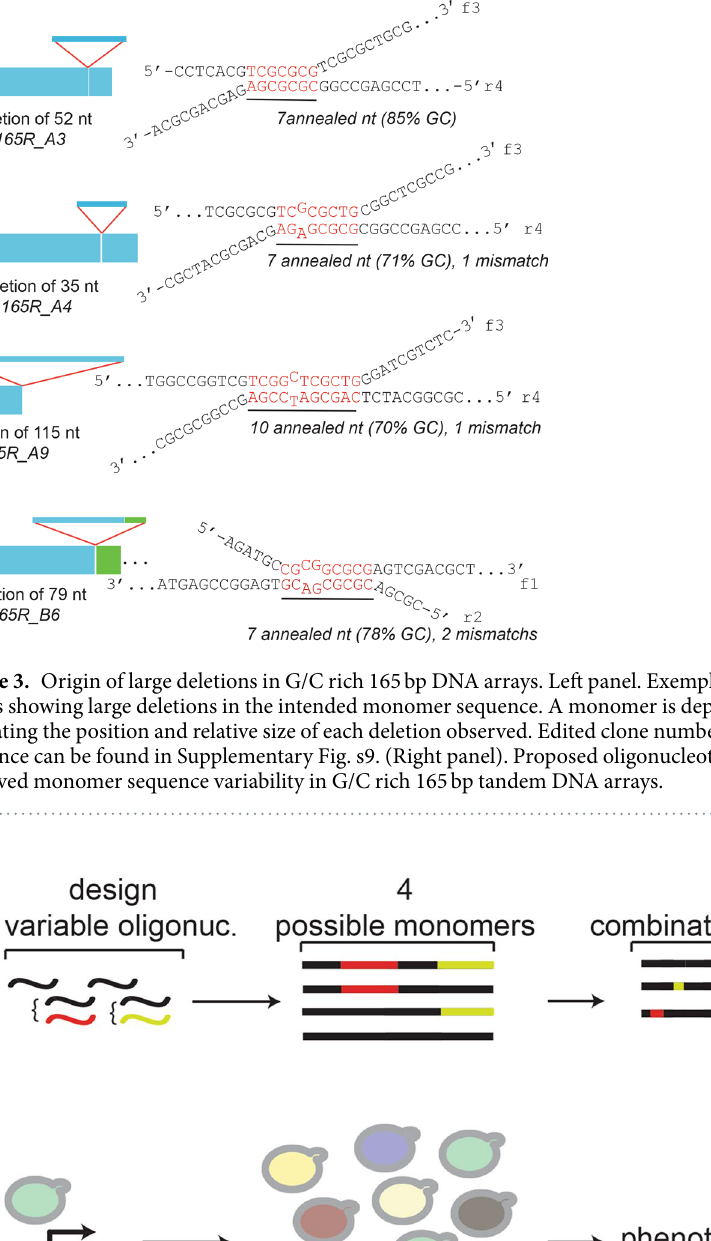
example to build spacer DNA between genetic elements 33 or for bottom-up engineering of regulatory regions, design of promoters 34 , e . g . with the introduction of transcription factor binding sequences in non overlapping